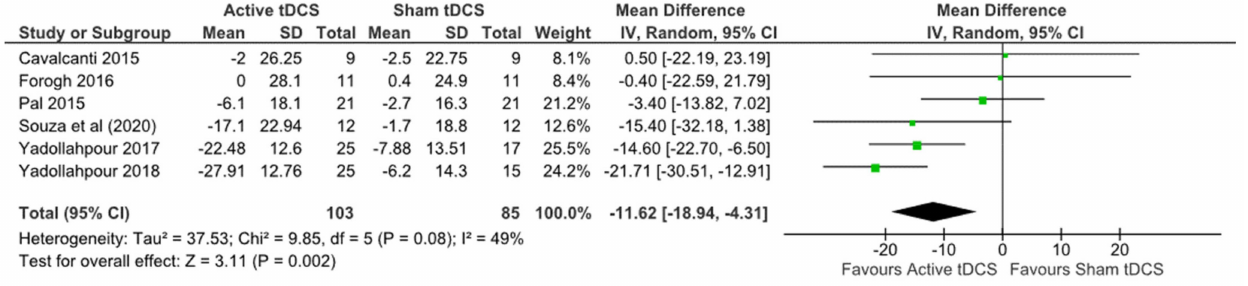
Figure 3. Forest plot